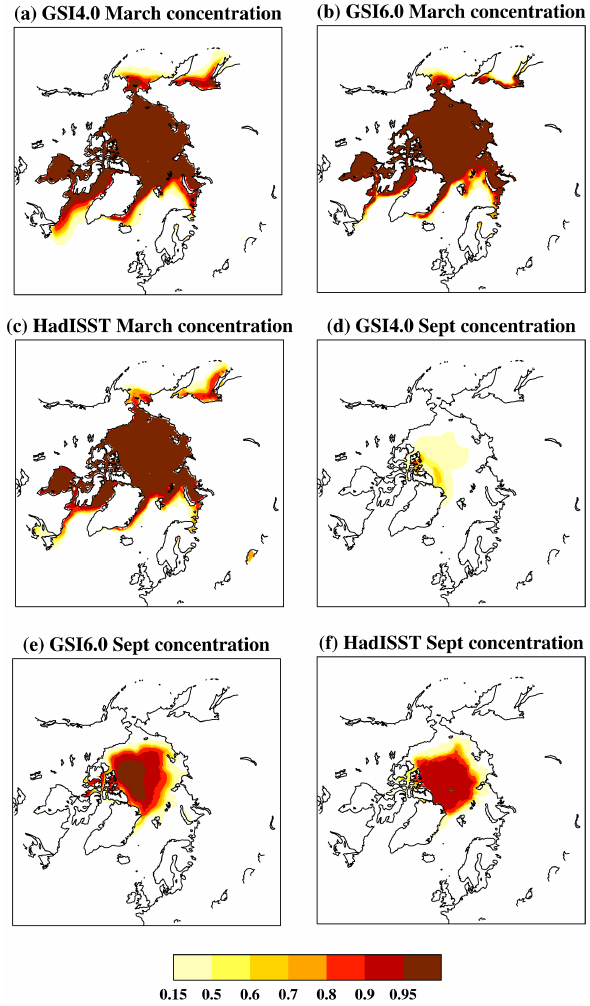
Figure 3. March and September 50-year mean Arctic sea ice con- centration in GSI4.0 and GSI6.0, and equivalent 11-year (1995– 2004) means for the HadISST data